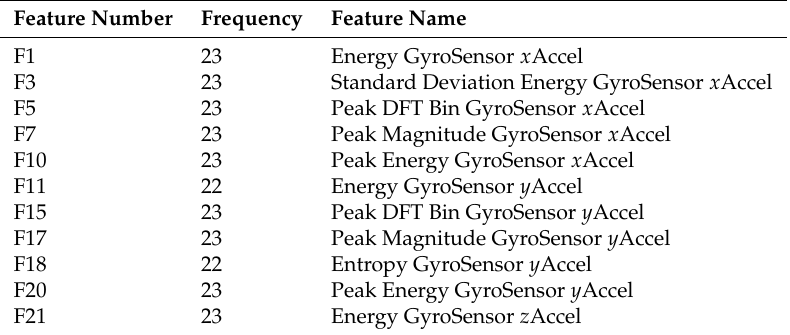
Table 6. Results of the correlation matrix analysis for feature selection in the extended PRIDE dataset. Only removed features are